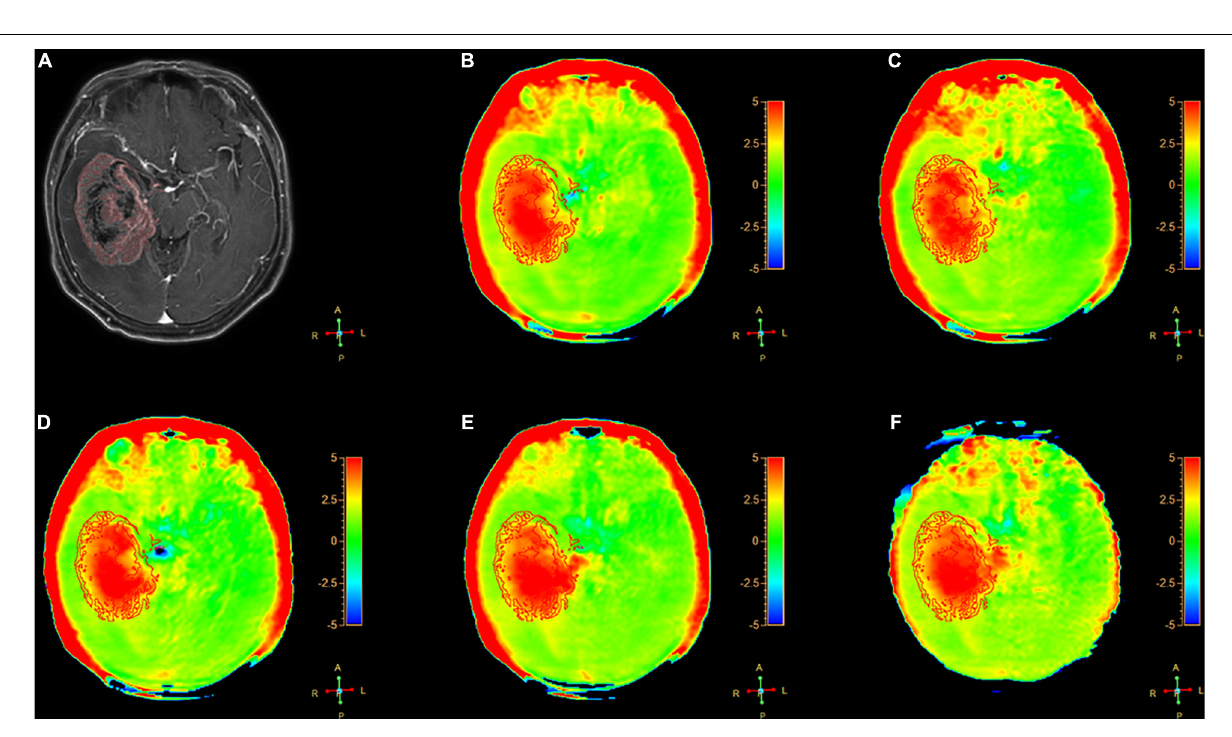
Frontiers in Neuroscience |